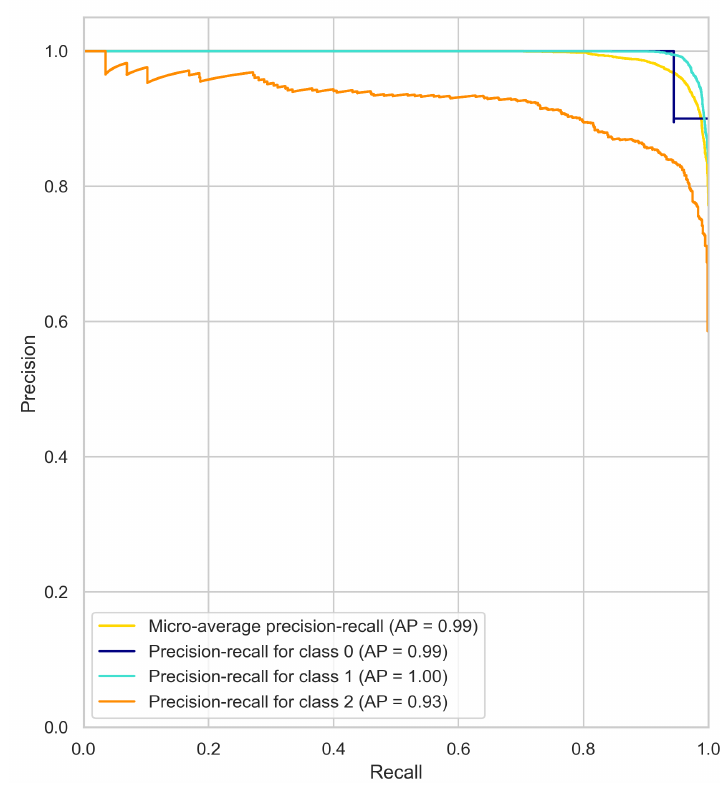
Figure 5. Precision–recall curve for multi-layer